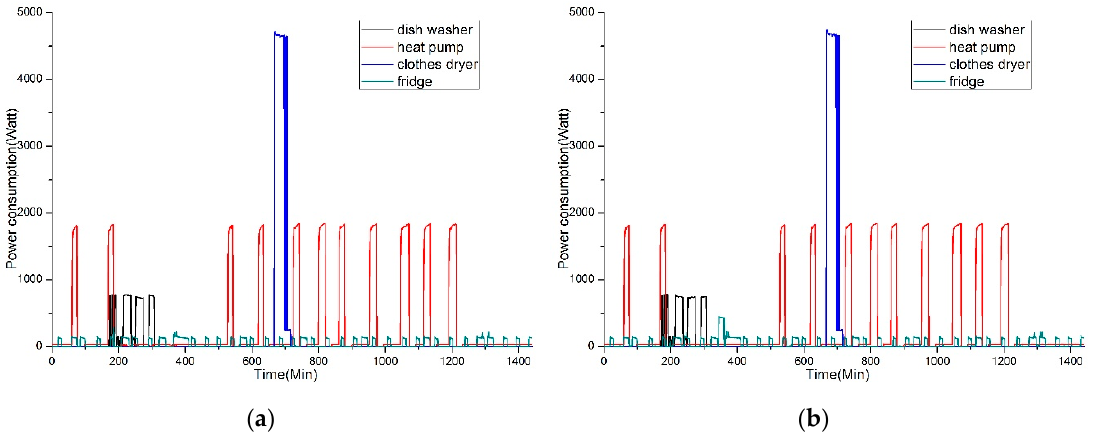
Figure 3. Load disaggregation result and the measured power of four appliances for a day. From left: ( a ) Load disaggregation result of four appliances in a day; ( b ) measured power values of four appliances in a day.